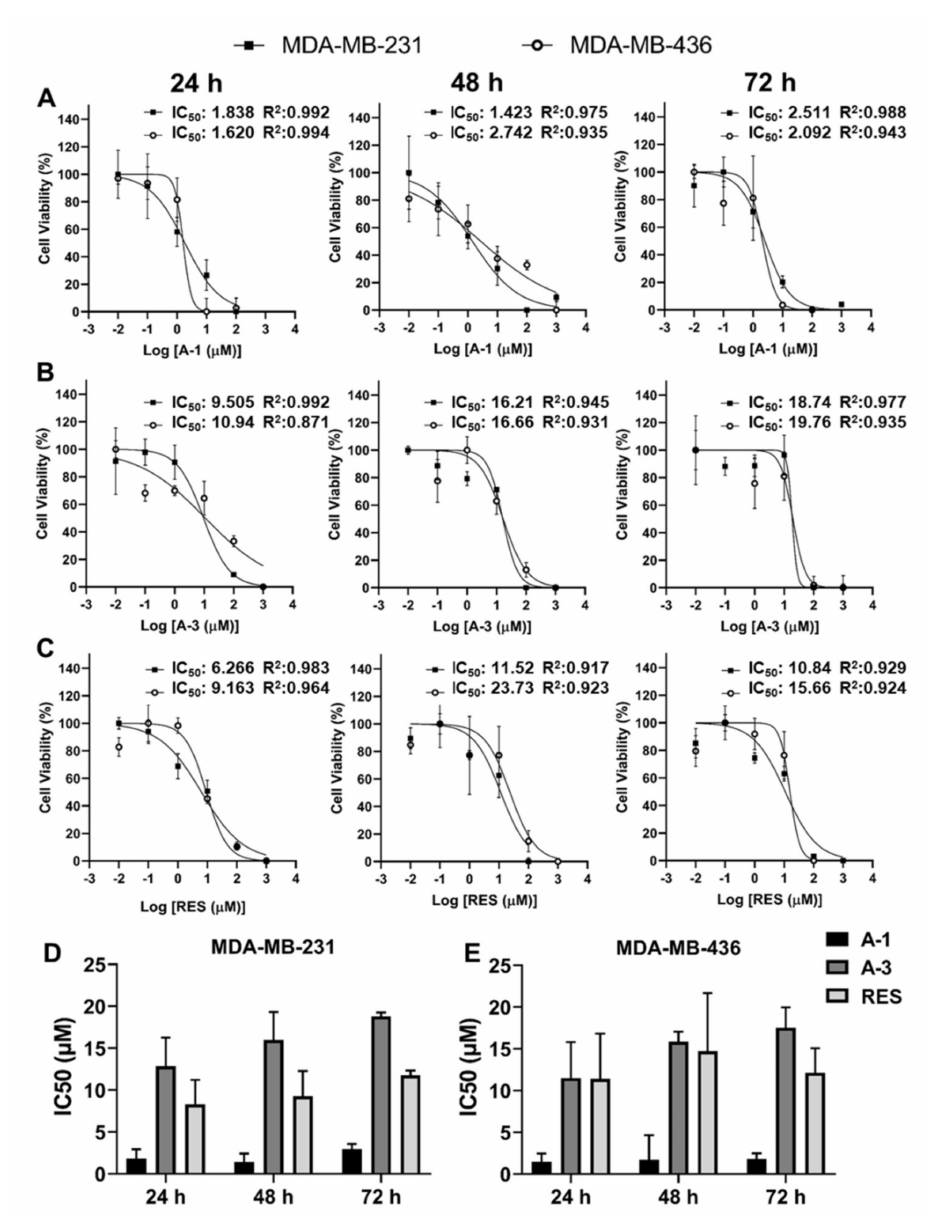
Figure 2. Effect of arachidin-1 (A-1), arachidin-3 (A-3), and resveratrol (RES) on cell proliferation. MDA-MB-231 and MDA-MB-436 cells were treated with various 10-fold concentrations from 0.01 µ M to 1000 µ M of ( A ) A-1, ( B ) A-3, and ( C ) RES for 24, 48, and 72 h. Cells with 0.1% DMSO were used as controls, wherein n = 3. ( D , E ) Summaries of the average IC 50 values from both cell lines are displayed. Each bar represents the mean of three individual experiments ±